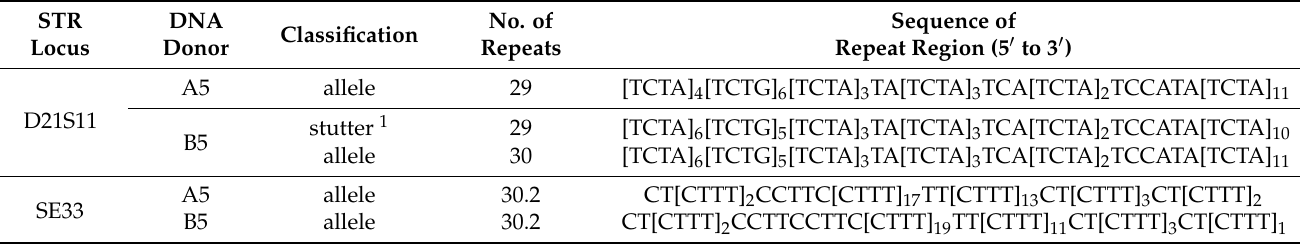
Table 2. Discrimination between stutters and alleles of the same length based on sequence.